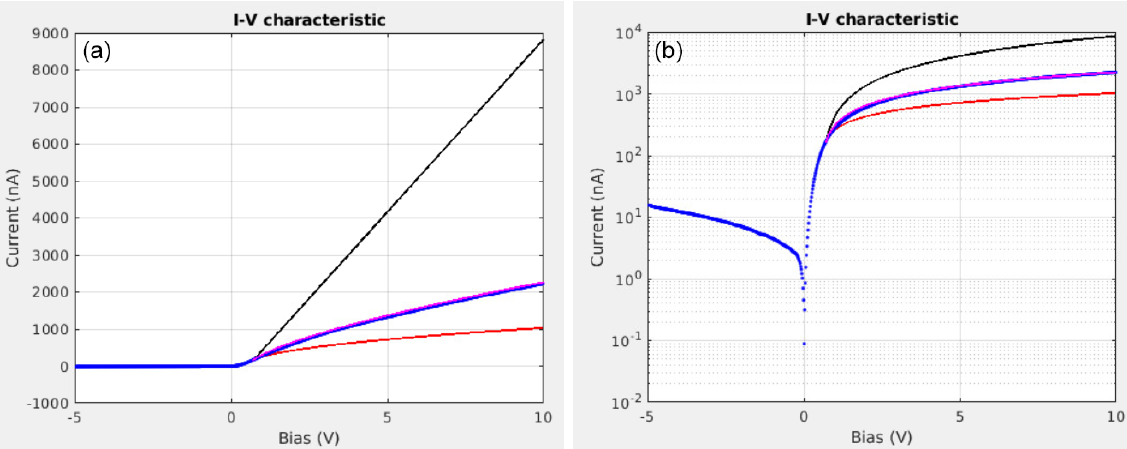
Figure 9. I-V characteristic with 840 data points. The blue dots are the measured data. The red, black and magenta lines are the computed data with γ = 0.5, γ = 1 and γ = 0.69, respectively. (a) Linear scale, (b) semi-logarithmic